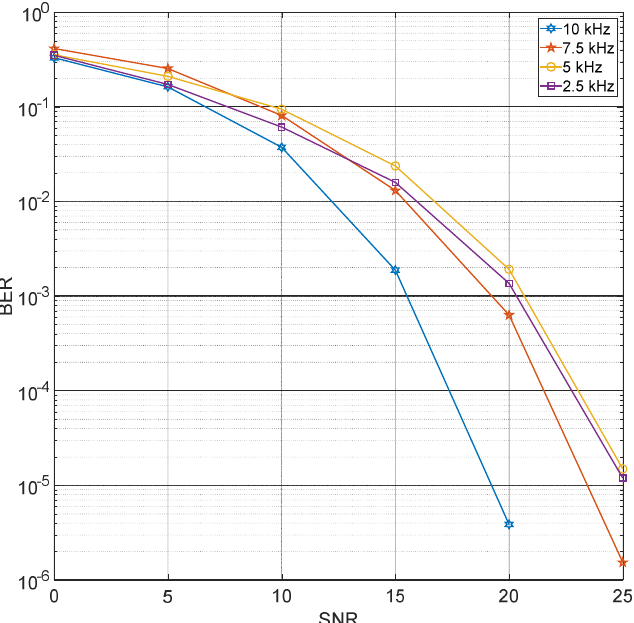
Figure 9. BER performance of CPM-OFDM as a function of channel bandwidth with N = 512, ℎ = 7/16 .